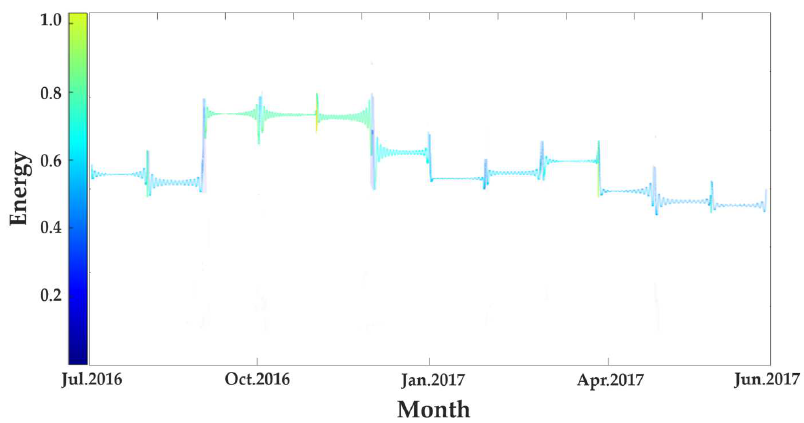
Figure 13. Hilbert spectrum of the annual generation waveform of tidal power.